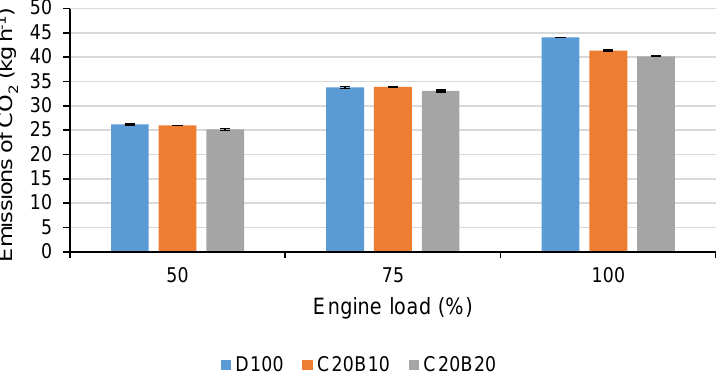
Figure 3. Emissions of CO 2 in relation to engine load for all tested fuels (error bars represent the standard deviation).